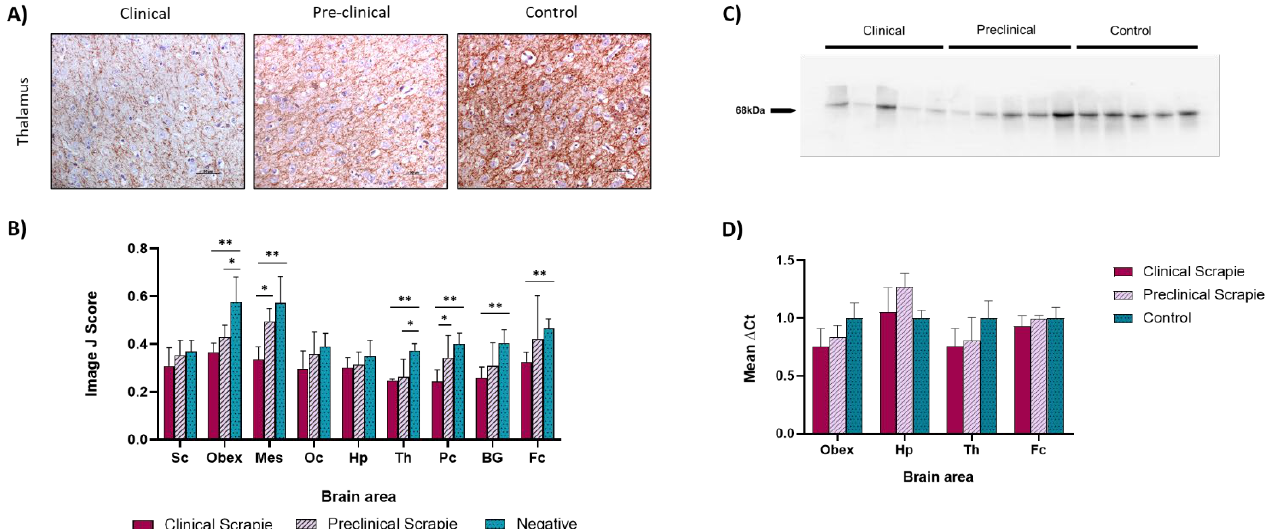
Figure 2. Study of NfL expression scrapie-infected and control sheep. ( A ) Images show the im- munostaining pattern for NfL found in the thalamus of the different study groups: clinical ( n = 8), preclinical ( n = 5), and control ( n = 8) sheep. Axonal and dendritic labeling can be observed. ( B ) Comparison of NfL Image J scores in the different studied brain areas of the three sheep groups: spinal cord (Sc), obex, mesencephalon (Mes), occipital cortex (Oc), hippocampus (Hp), thalamus (Th), parietal cortex (Pc), basal ganglia (BG), and frontal cortex (Fc). Control sheep exhibited the highest scores in all brain areas, followed by preclinical animals, while clinical sheep showed the lowest scores. Evaluation of differences between groups was performed using the one-way ANOVA test followed by the Bonferroni post hoc test (* p < 0.05 and ** p < 0.01). Data represent the mean ± SEM. ( C ) Western blot analyses for NfL in the frontal cortex of sheep. Samples corresponding to the frontal cortexes of clinical, preclinical, and negative sheep were analyzed. A single band at ~68 kDa was detected, confirming the specificity of the anti-NfL antibody. ( D ) Figure showing the mRNA expression profiles of the NfL-encoding gene in the obex, hippocampus, thalamus, and frontal cor- tex of the three groups of sheep. Relative expression levels are expressed as the mean ± standard deviation. The results were normalized using the expression of SDHA and GAPDH housekeeping genes. The expression values were determined using the 2 −∆∆Ct method, and differences between experimental groups were assessed using the one-way ANOVA test followed by the Bonferroni post hoc test. No significant differences were found.